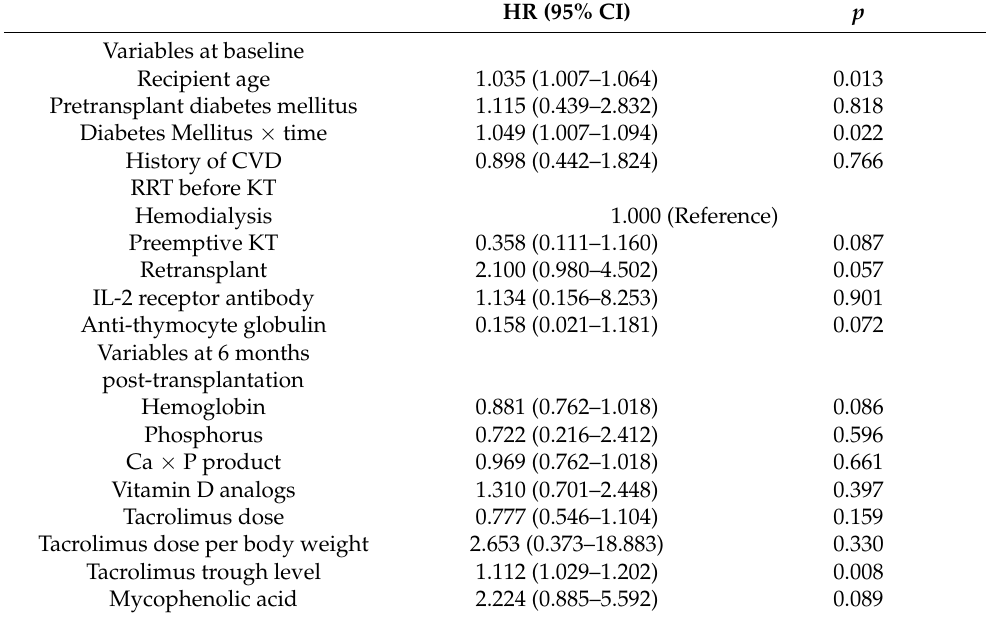
Table 4. Multivariable Cox regression for risk factors for incident fractures of the kidney transplant recipients with diabetes mellitus as a continuous time-dependent